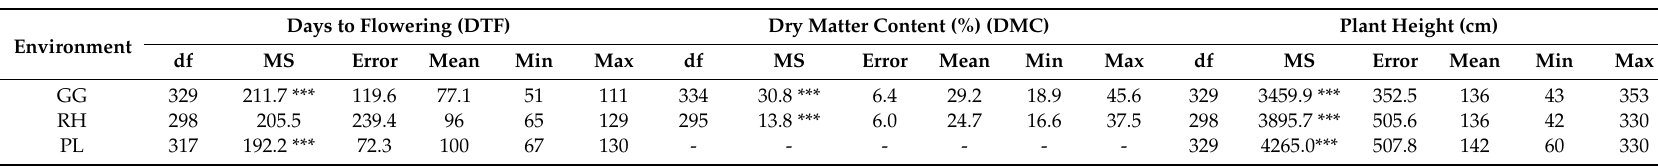
Table 7. Genotypic variances (mean squares, MS) and descriptive statistical traits for days to flowering, dry matter content, and plant height, separately for the di ff erent environments. Genotypic variances were computed using a general linear model in which genotypes were considered as fixed and replicates as random e ff ects (see Material and Methods).